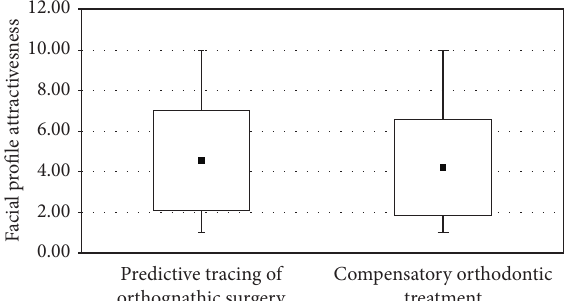
Figure 4: Boxplot of the score of facial profile attractiveness of predictive tracing of orthognathic surgery and orthodontic camouflage.